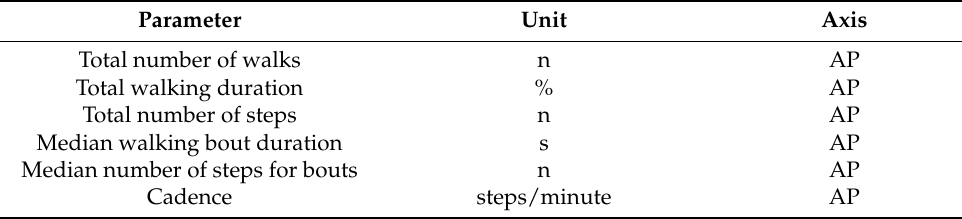
Table 1. Gait parameters related to the quantity of walking.